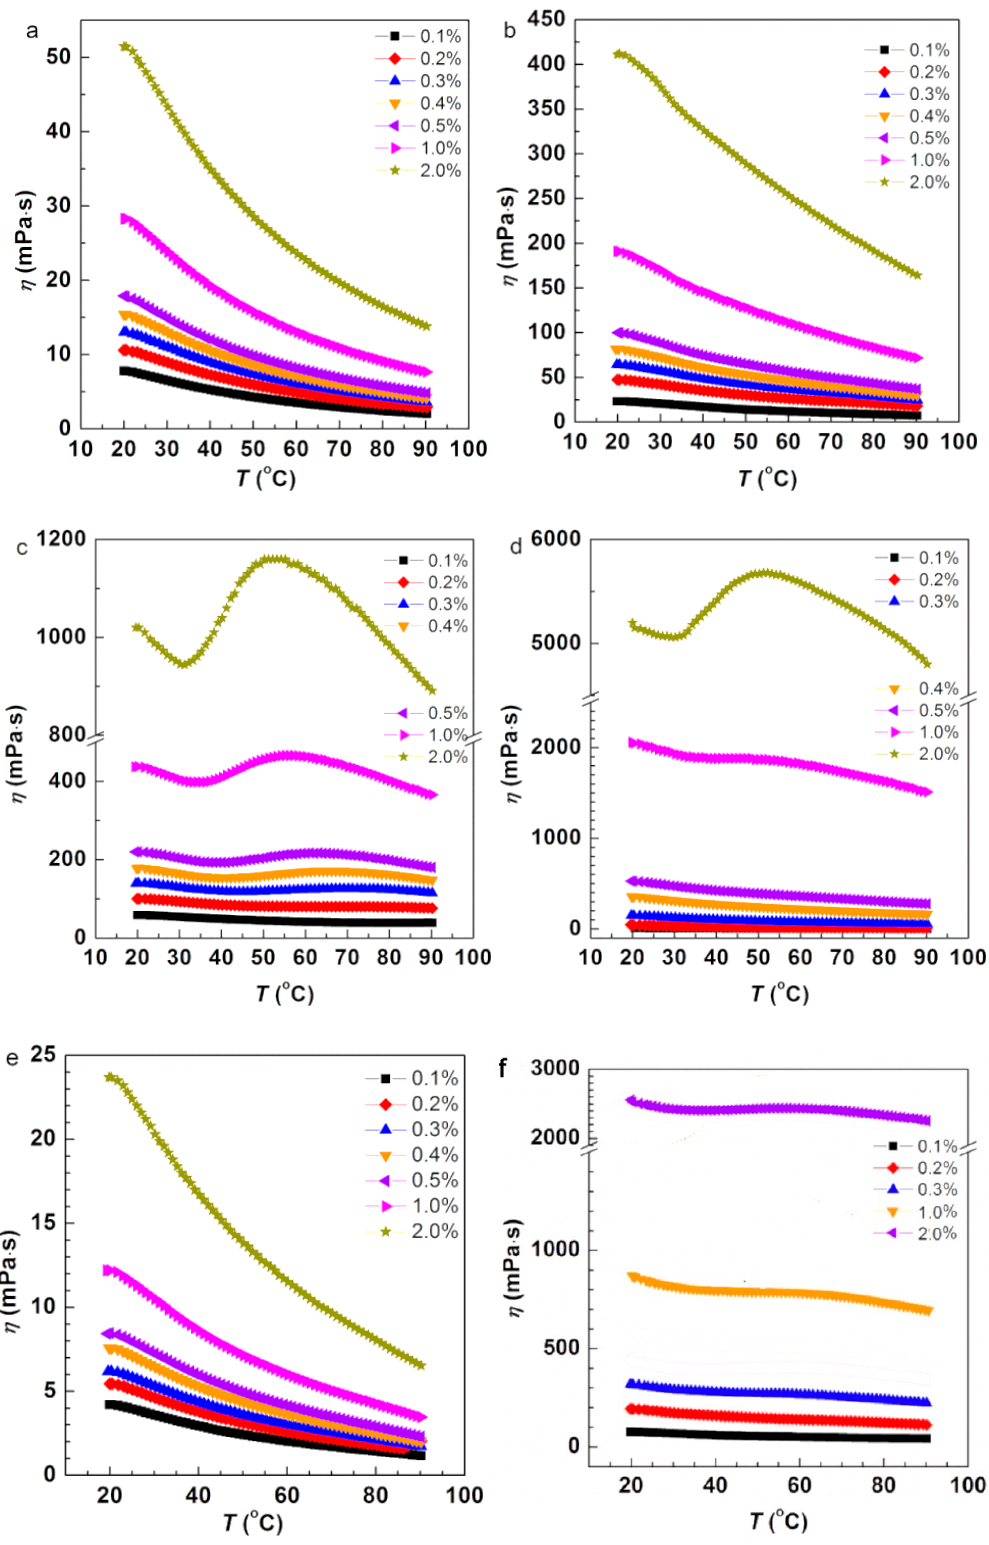
Figure 6. Apparent viscosity plotted as a function of polymer concentration for ( a ) S1, ( b ) S2, ( c ) S3, ( d ) S4, ( e ) S5 and ( f ) unmodified Pluronic F127 in pure water (shear rate =10 s − 1 ).